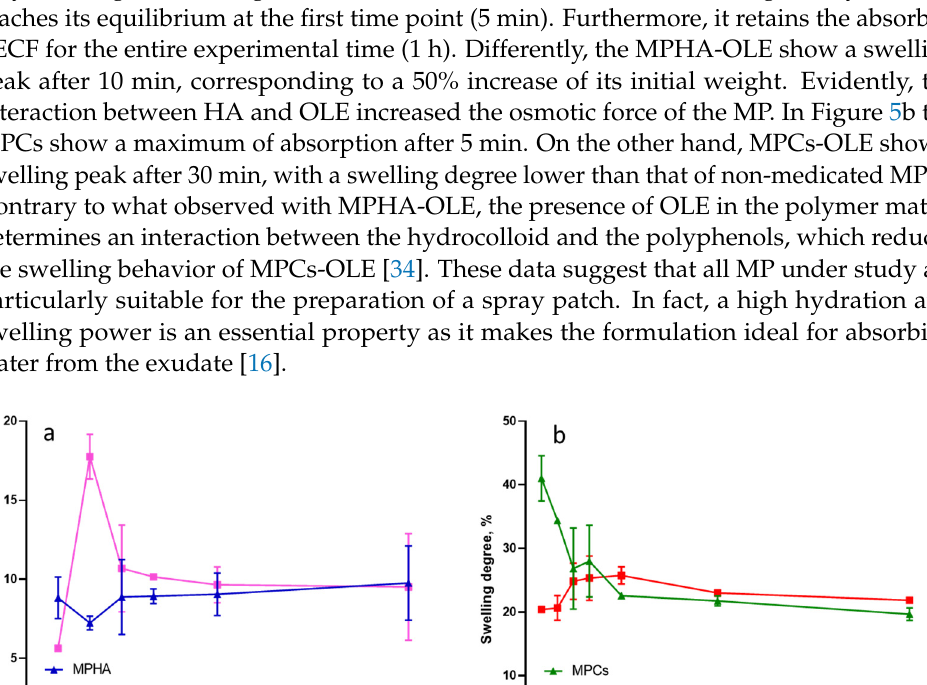
Figure 4. OLE stability in pseudo extracellular fluid (PECF) at 37 °C. Means ± SD ( n = 4).